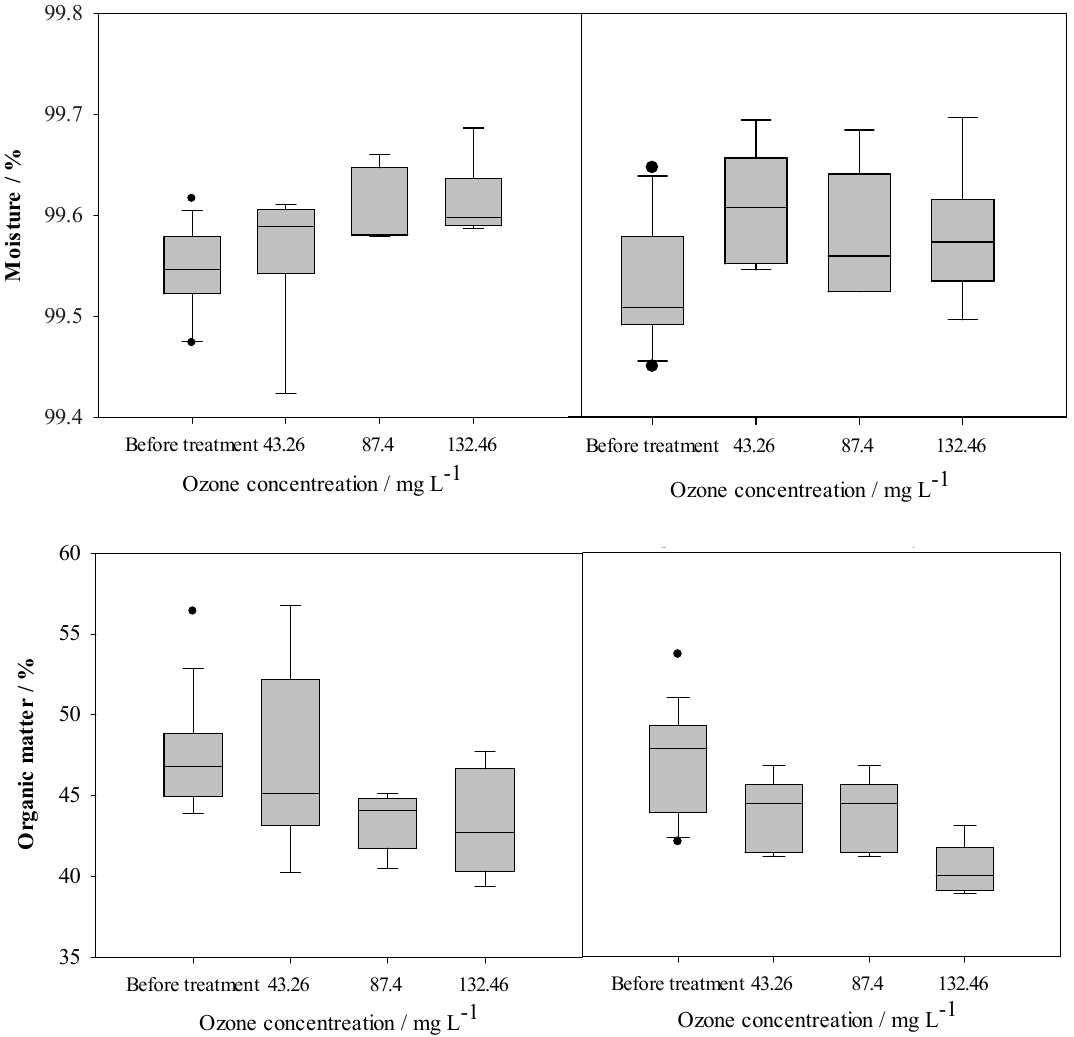
Figure 6. The change in moisture content and organic matter of dairy manure during O 3 treatment ( left side figures showed moisture content and organic matter in raw manure; right side figures showed moisture and organic matter in autoclaved manure, and black dots indicate